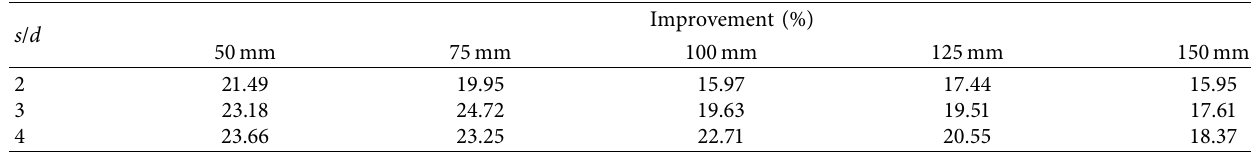
Table 4: Improvement in DL-GESC compared to